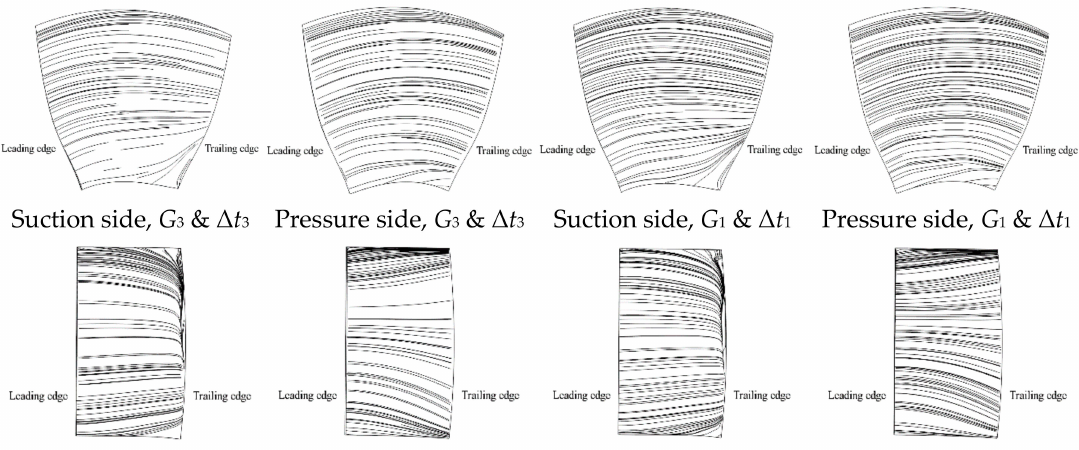
Figure 7. Limiting streamlines on rotor ( top row ) and stator ( bottom row ) blade surfaces, Q = 0.42 m 3